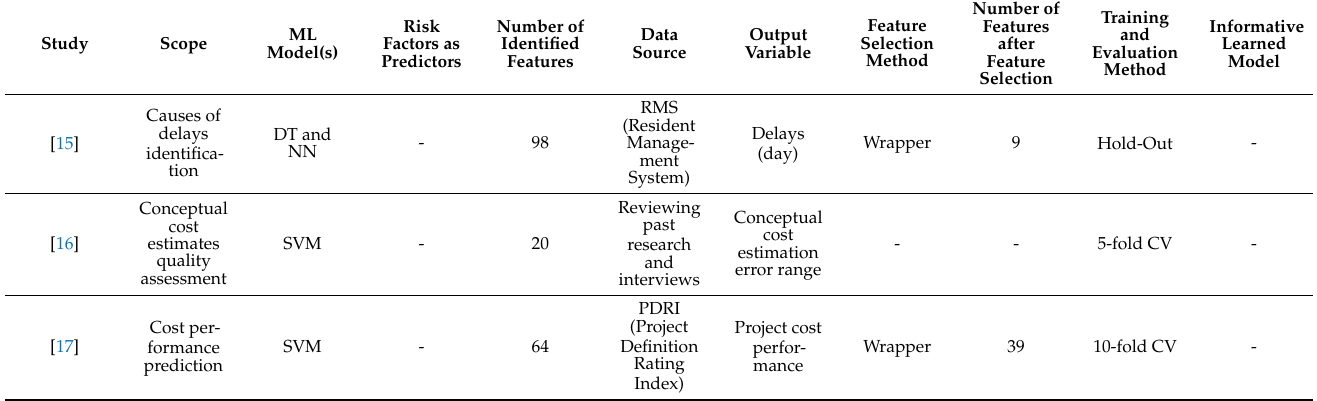
Table 1. A taxonomy of the existing literature on project cost overrun and delay: prediction and